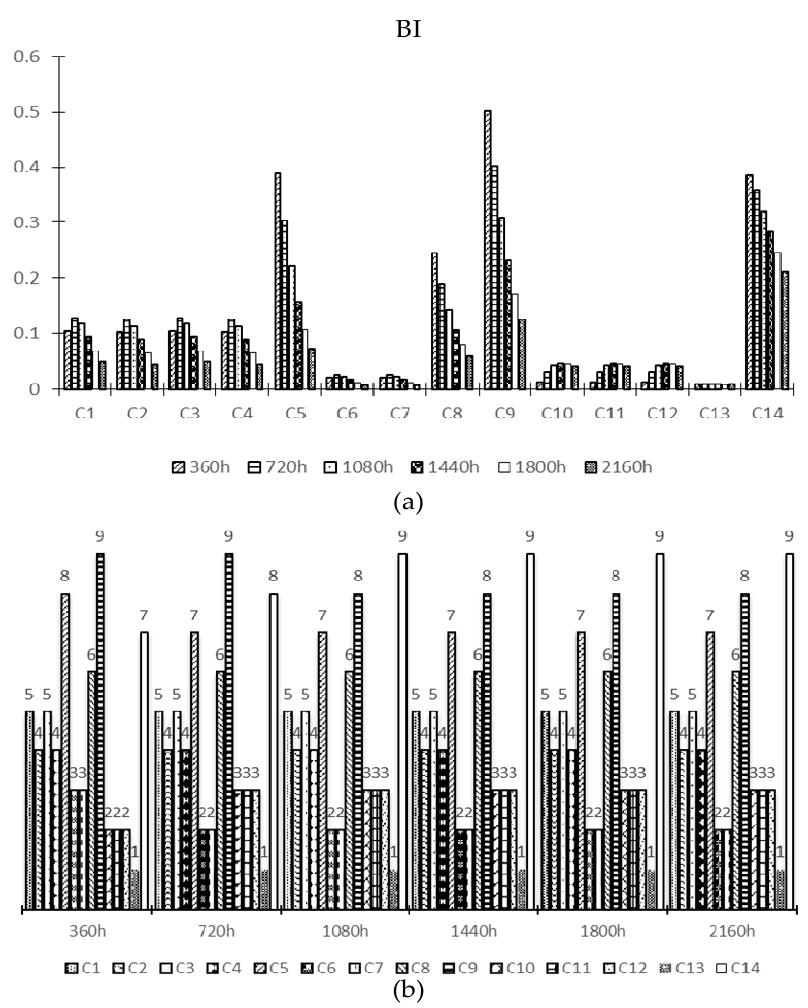
Figure 9. BI values ( a ) and ranking bar charts ( b ) of the fourteen-component system when P N is less than P out .